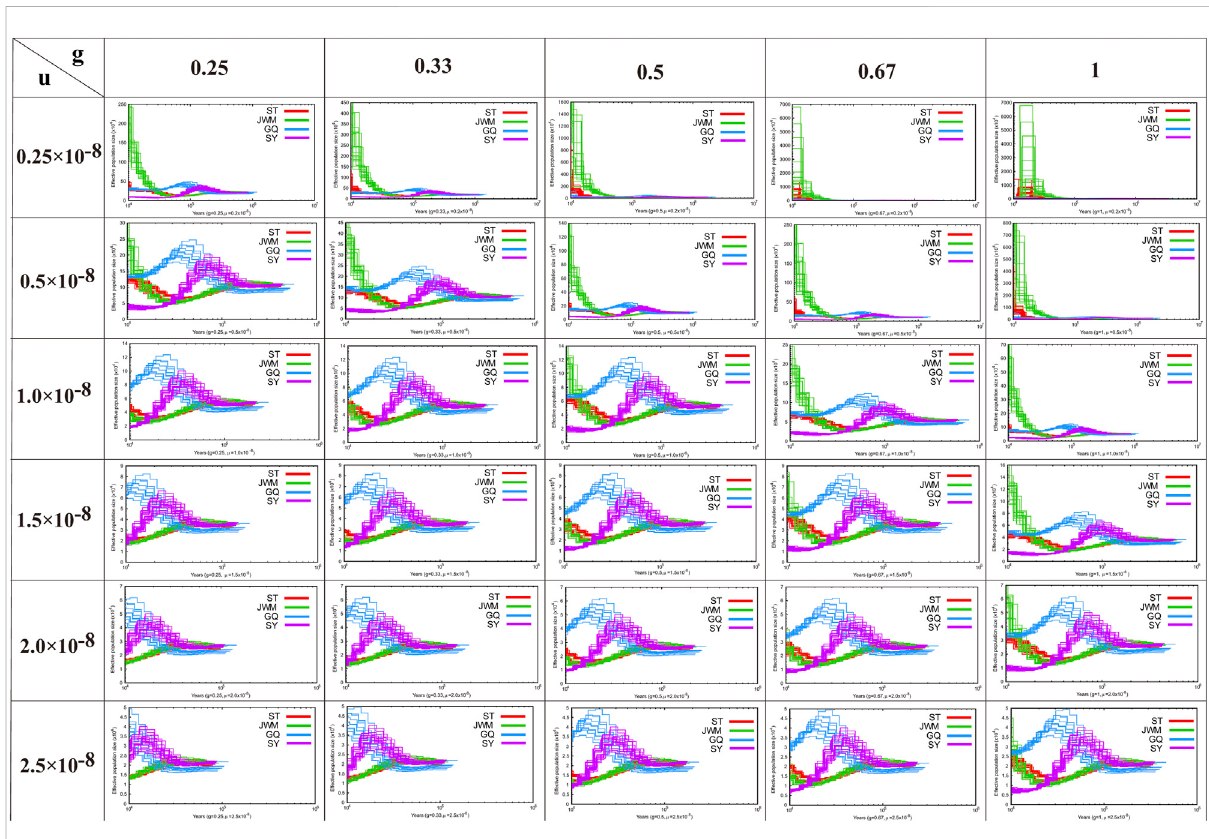
FIGURE 5 The results of the analysis of the demographic history of the O. curvintous are presented. Multiple values ranging from 0.25 × 10 − 8 to 2.5 × 10 − 8 were used for mutation rates (u). The generation intervals (g) were 0.25, 0.33, 0.5, 0.66, and 1 year based on the sexual maturity time of the medaka and fi eld surveys.